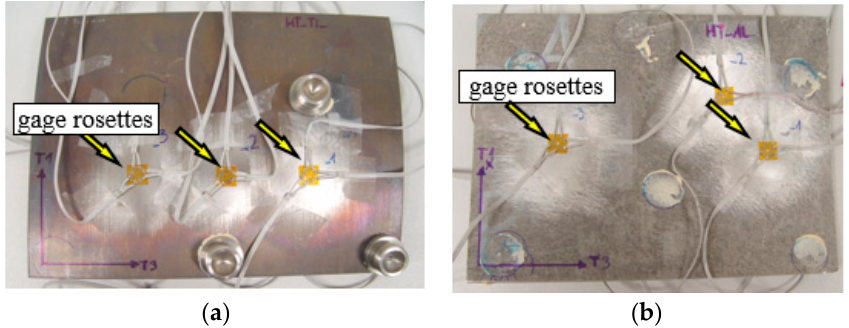
Figure 5. Arrangement of gauge rosettes on TiAl4V side 9 ( a ) AA2519 ( b ) .